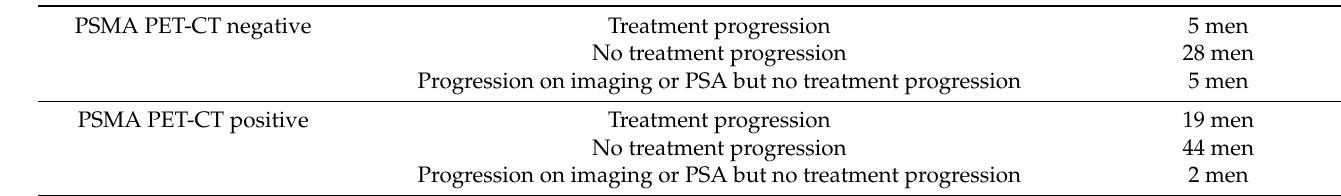
Table 6. PSMA PET-CT as a predictor of treatment progression.